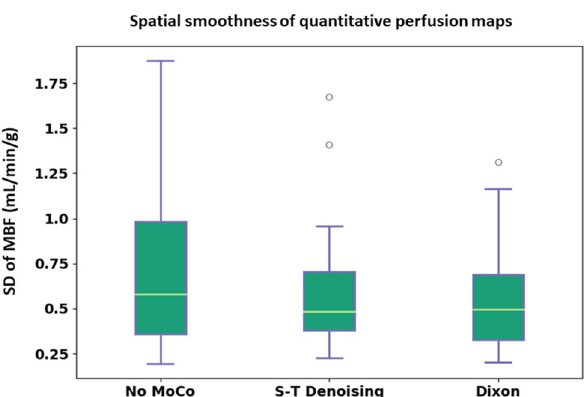
Figure 6. Example quantitative MBF maps for one image slice from three representative patients (columns) are shown for the three motion correction states (no MoCo, S-T denoising and Dixon MoCo, respectively) (rows). The presence of motion in the images without motion correction (no MoCo) manifests itself as spurious areas of large MBF values. This is eradicated to a certain extent in the S-T denoising images and almost completely in the Dixon MoCo images. Further MBF maps are shown in the supplementary material Fig. S1.